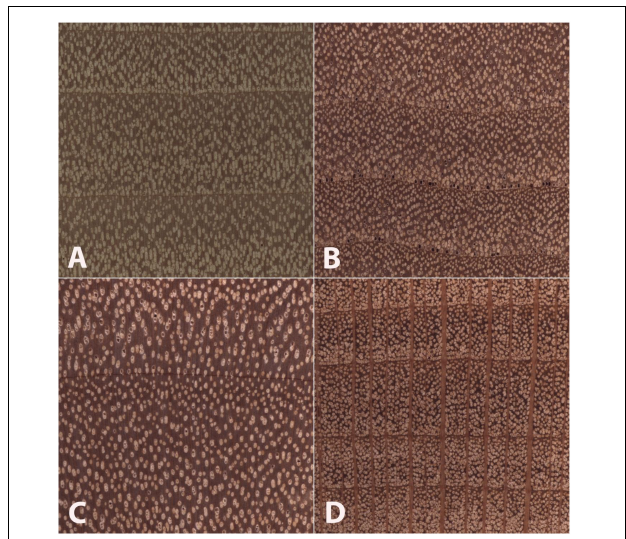
FIGURE 5 | Images of the transverse surface of test specimens (B–D) and an exemplar (A) of the class (Populus) to which each was assigned in the field model. All images are 6.35 mm on a side. An anatomically representative specimen of Salix scouleriana (B) was misclassified as the wood anatomically similar class Populus (A) , a Type 1 misclassification. An anatomically atypical specimen of Betula nigra (C) was classified as (A) , a Type 2 misclassification. An anatomically typical specimen of Platanus occidentalis (D) was misclassified as the anatomically disparate class (A) , a Type 3 misclassification. Note the anatomical similarities between panels (A,B) , and to a lesser extent panels (A,C) , and the anatomical dissimilarity between panels (A,D) , especially with regard to the wide rays in panel (D) .